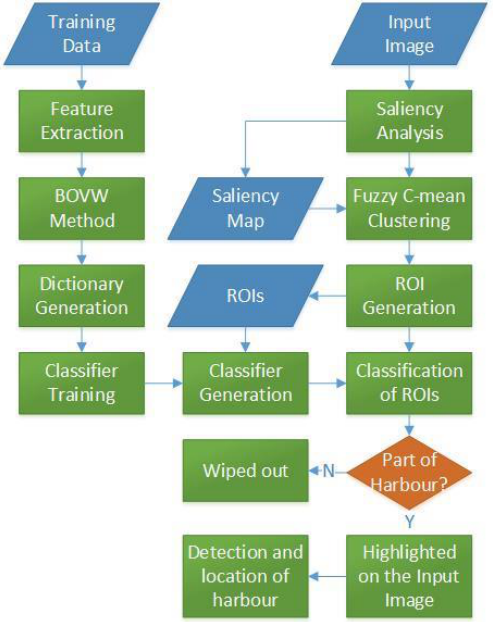
Figure 1. Procedure of the proposed